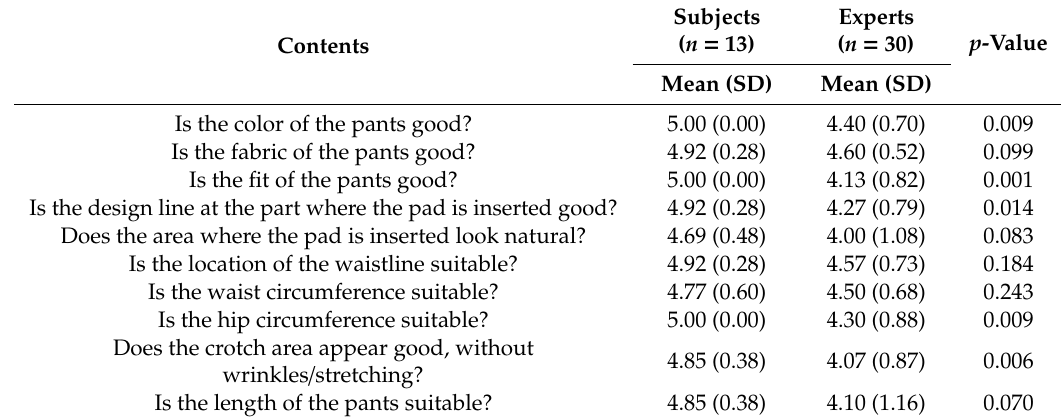
Table 7. Results of appearance evaluation.